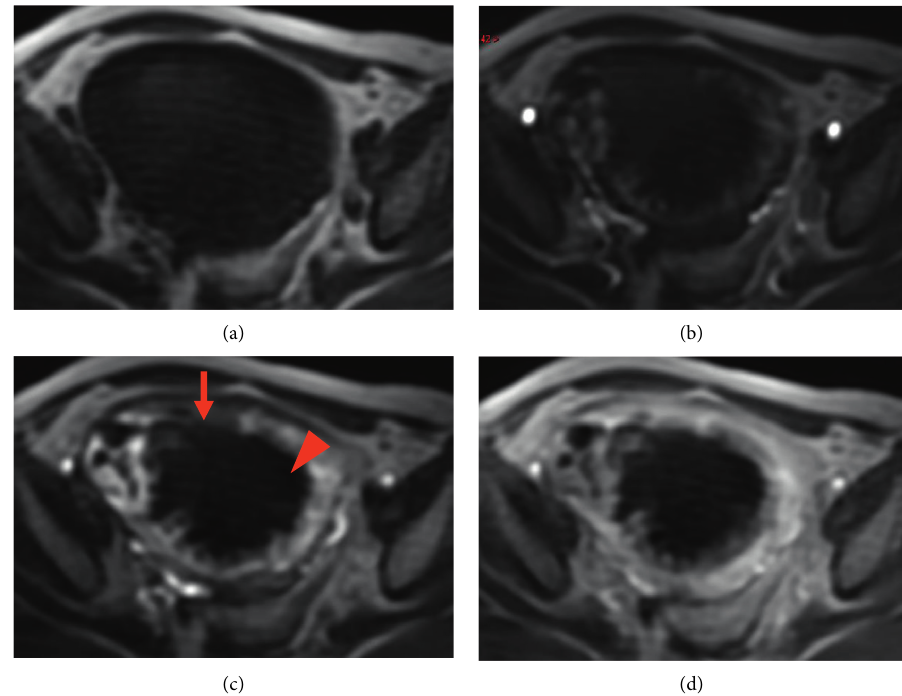
Figure 8: Pelvic MRI of leiomyosarcoma: (a, b, c, d) axial DCE-MRI without injection (a), at arterial phase (b), venous phase (c), and late phase (d). Note the disruption of the peripheral vascular ring (arrow) and heterogeneity due to central necrosis (arrowhead) (c).